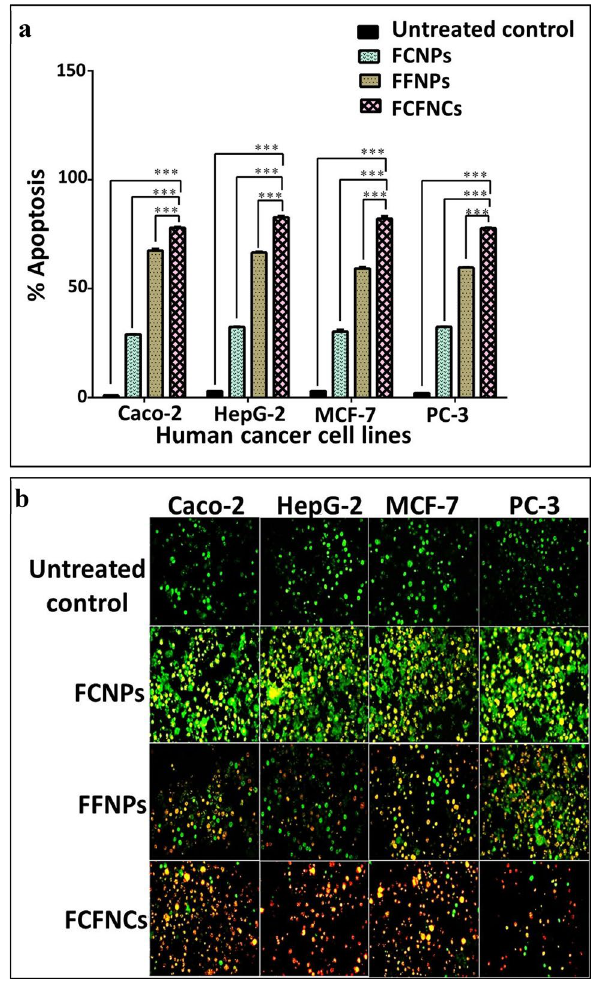
Figure 4. Apoptotic cell population in FCNPs , FFNPs and FCFNCs-treated human cancer cells compared with the untreated cancer cell lines. The percentage of apoptosis in the control and treated cancer cells using flow cytometry after staining with annexin V/propidium iodide ( a ). Fluorescence images of AO/EB double staining with green, yellowish-orange, and red fluorescence indicate viable, early apoptotic and late apoptotic cells, respectively (magnification × 200) ( b ). All values were expressed as mean ± SEM. FCFNCs were compared with FCNPs and FFNPs. This comparison considers significantly different at *p < 0.05, **p < 0.005, ***p <